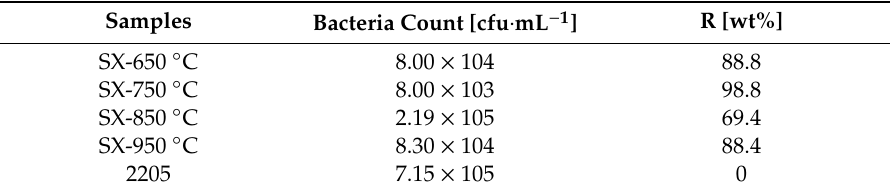
Table 3. Antibacterial rates (R) of the samples after 24 h interaction with the bacterial